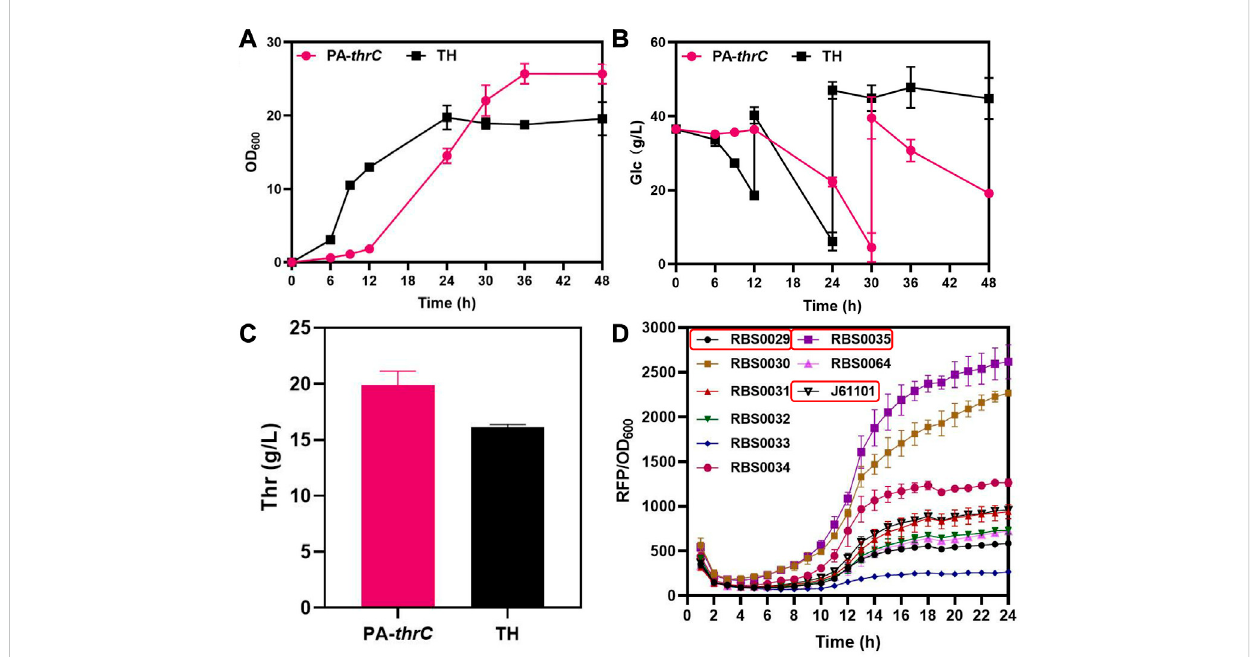
FIGURE 2 Comparisonofthefermentationresultsofoverexpressed thrC bymediumcopyPACYC-DuetplasmidandcontrolTHandcharacterizationresultsof different RBS intensities. The PA-ThrC strain overexpresses thrC on the PACYC-Duet plasmid. All results were derived from three ( n = 3) independent repeats. (A) Comparison of cell growth (OD 600 ) between overexpressing thrC and control strains. (B) Glucose consumption by the overexpressing thrC andcontrolstrains. (C) ComparisonofL-threoninetiterbetweentheoverexpressing thrC strainandthecontrolstrainafterfermentationfor48 h. (D) The fl uorescence intensity of RFP was monitored in real-time by a multi-detection microplate reader to characterize and screen RBS with different intensities. The RBS intensity was calculated using the ratio of RFP to OD 600